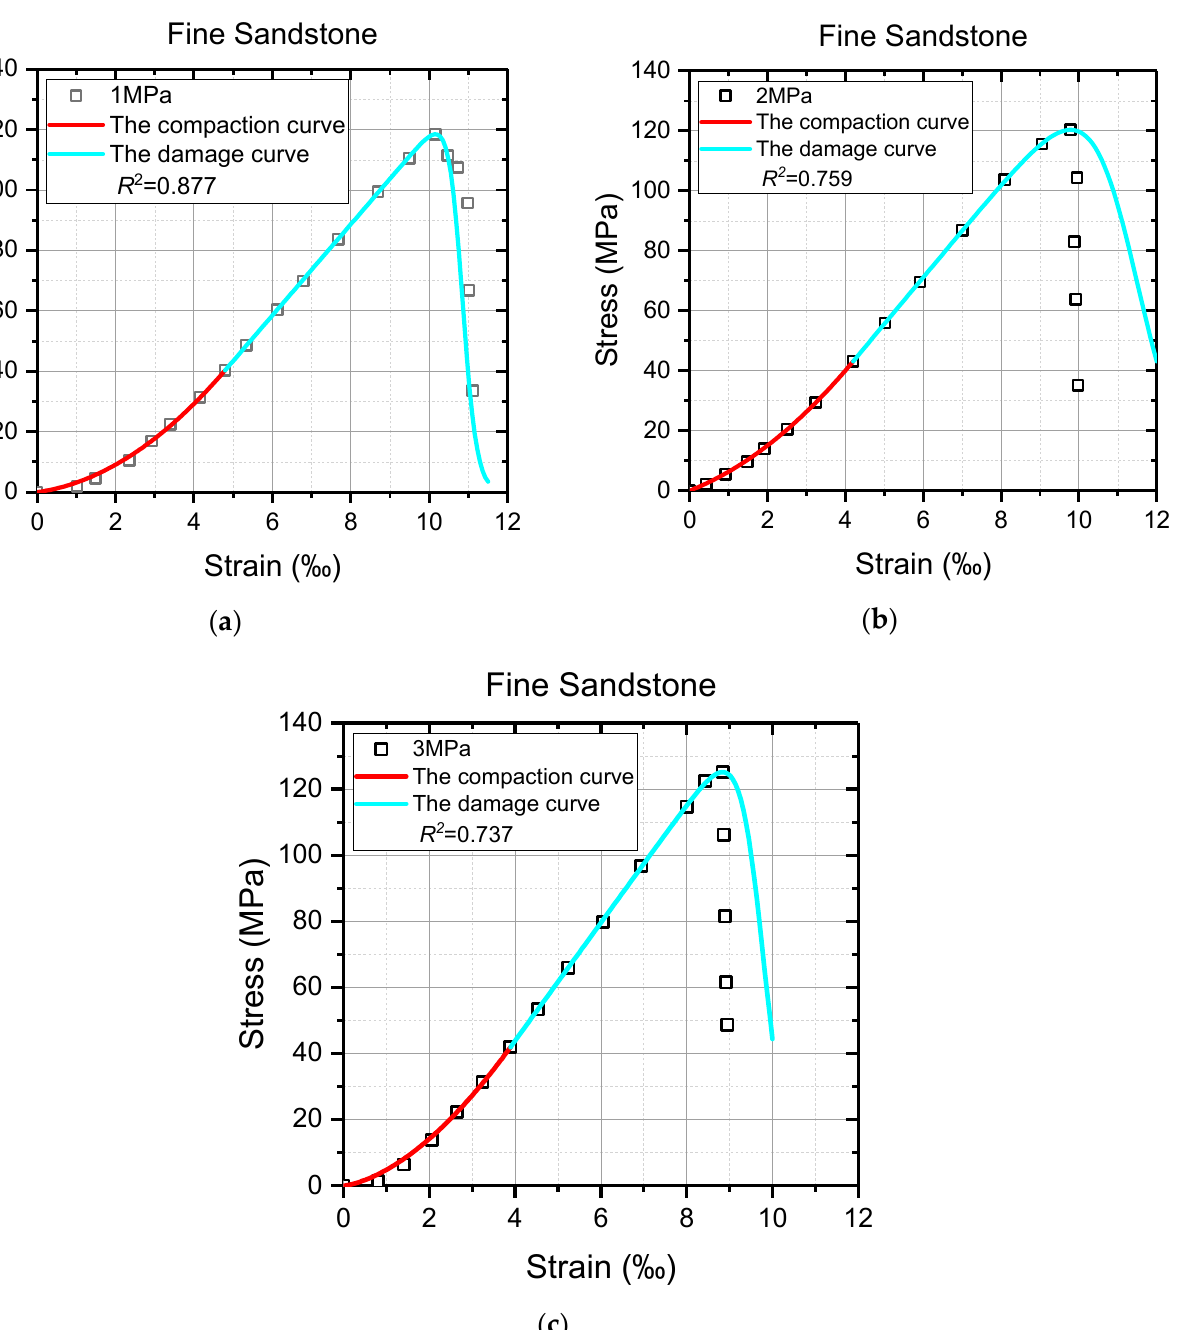
Figure 11. The comparison between partial triaxial test data and model curves of fine sandstone. ( a ) Confining stress = 1 MPa; ( b ) confining stress = 2 MPa; ( c ) confining stress = 3 MPa.